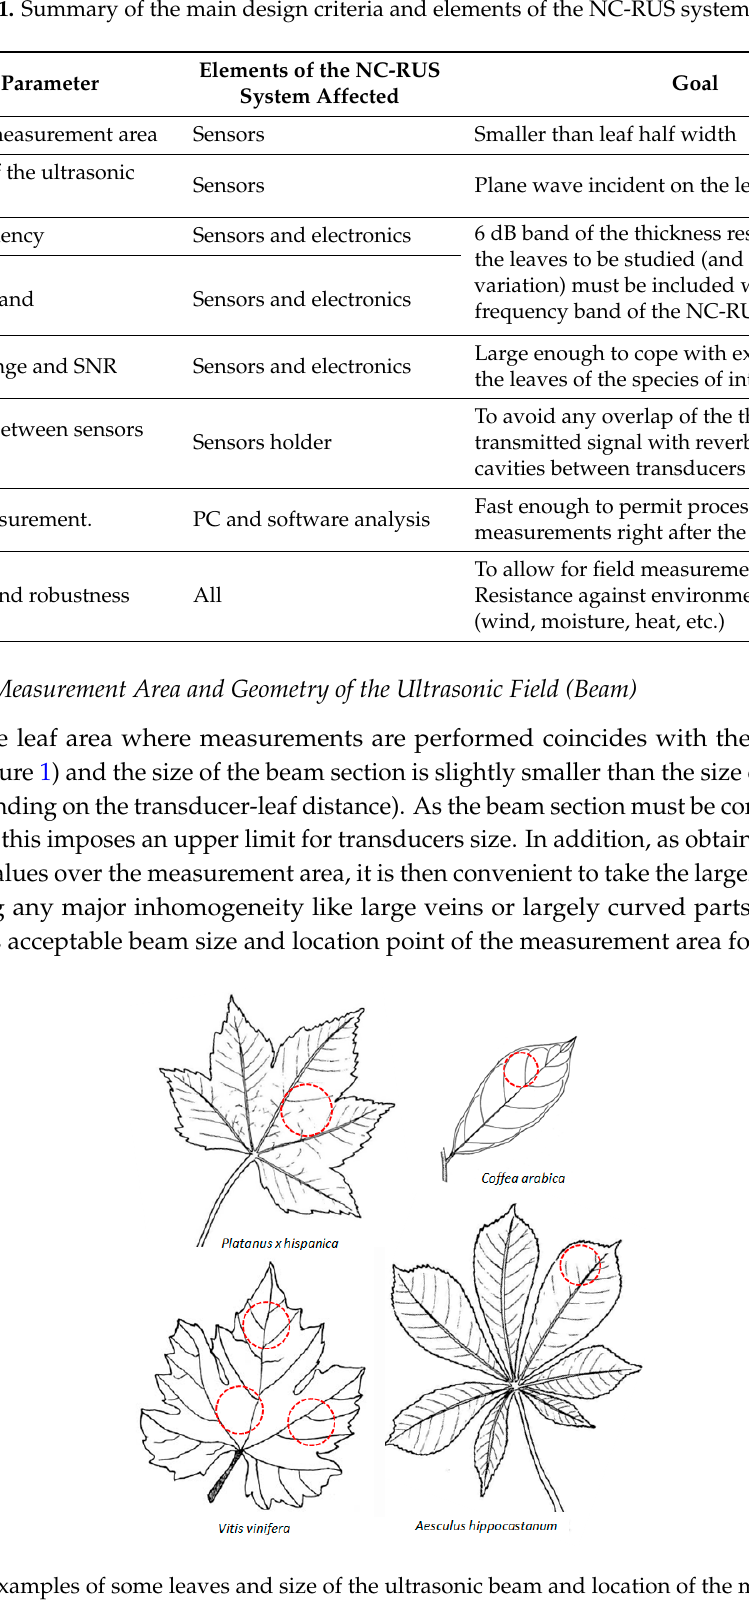
Figure 2. Examples of some leaves and size of the ultrasonic beam and location of the measurements.